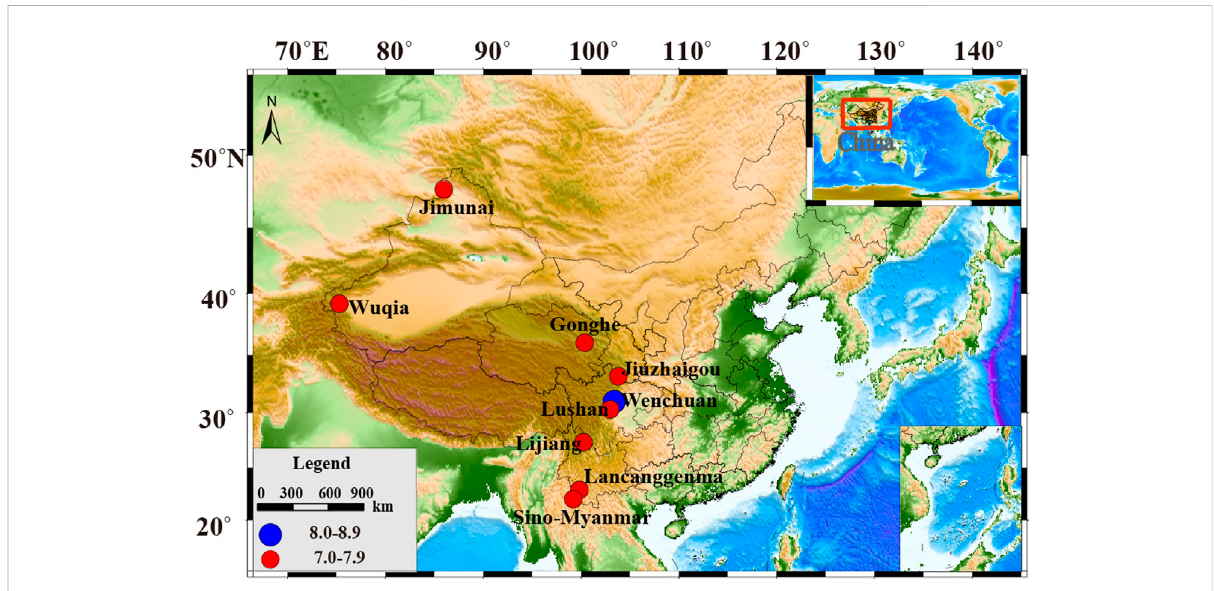
FIGURE 1 Locations of 9 M s ≥ 7.0 earthquakes in mainland China. Red circles represent magnitude-7.0 – 7.9 earthquakes, and blue circles represent magnitude-8.0 – 8.9 earthquakes, the spatial distribution of epicenters in the Chinese mainland from 1980 to